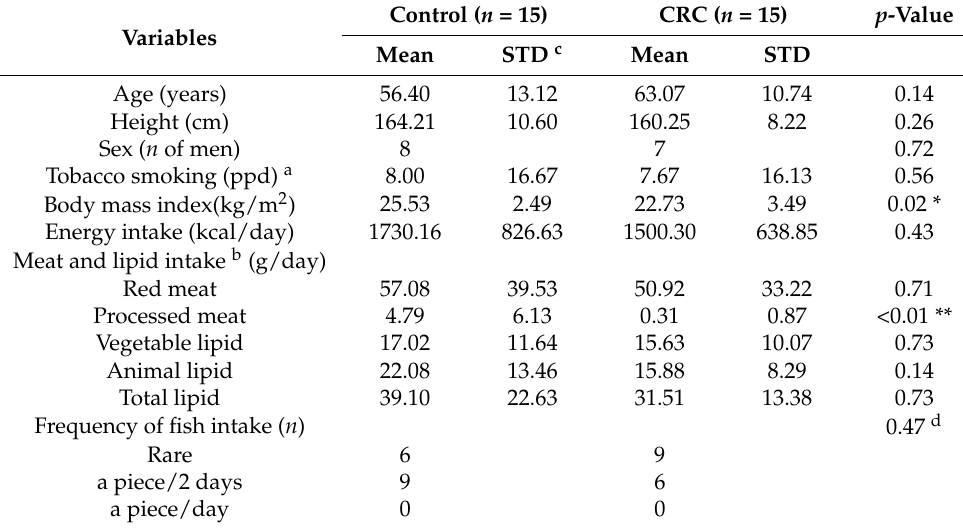
Table 1. Characteristics of all subjects.